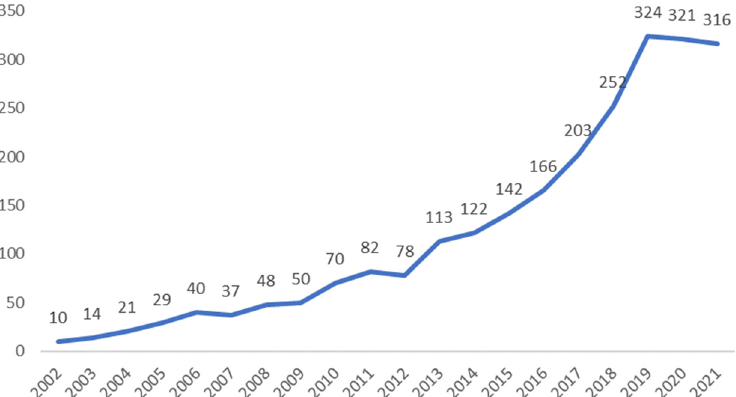
Figure 1. The number of global publications on urban form and carbon emissions (2002–2021).